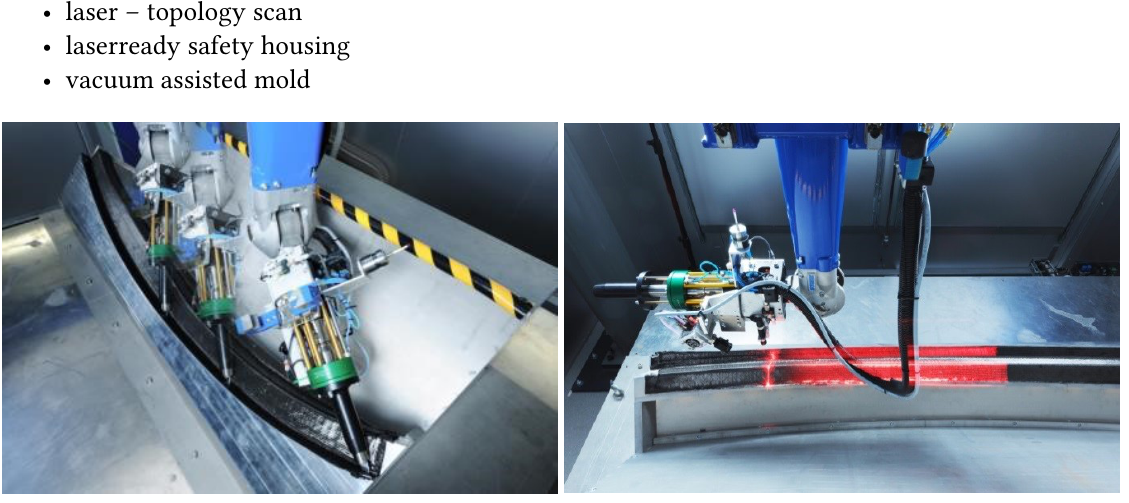
Figure 7: Net shape trimming (left) and laser scan